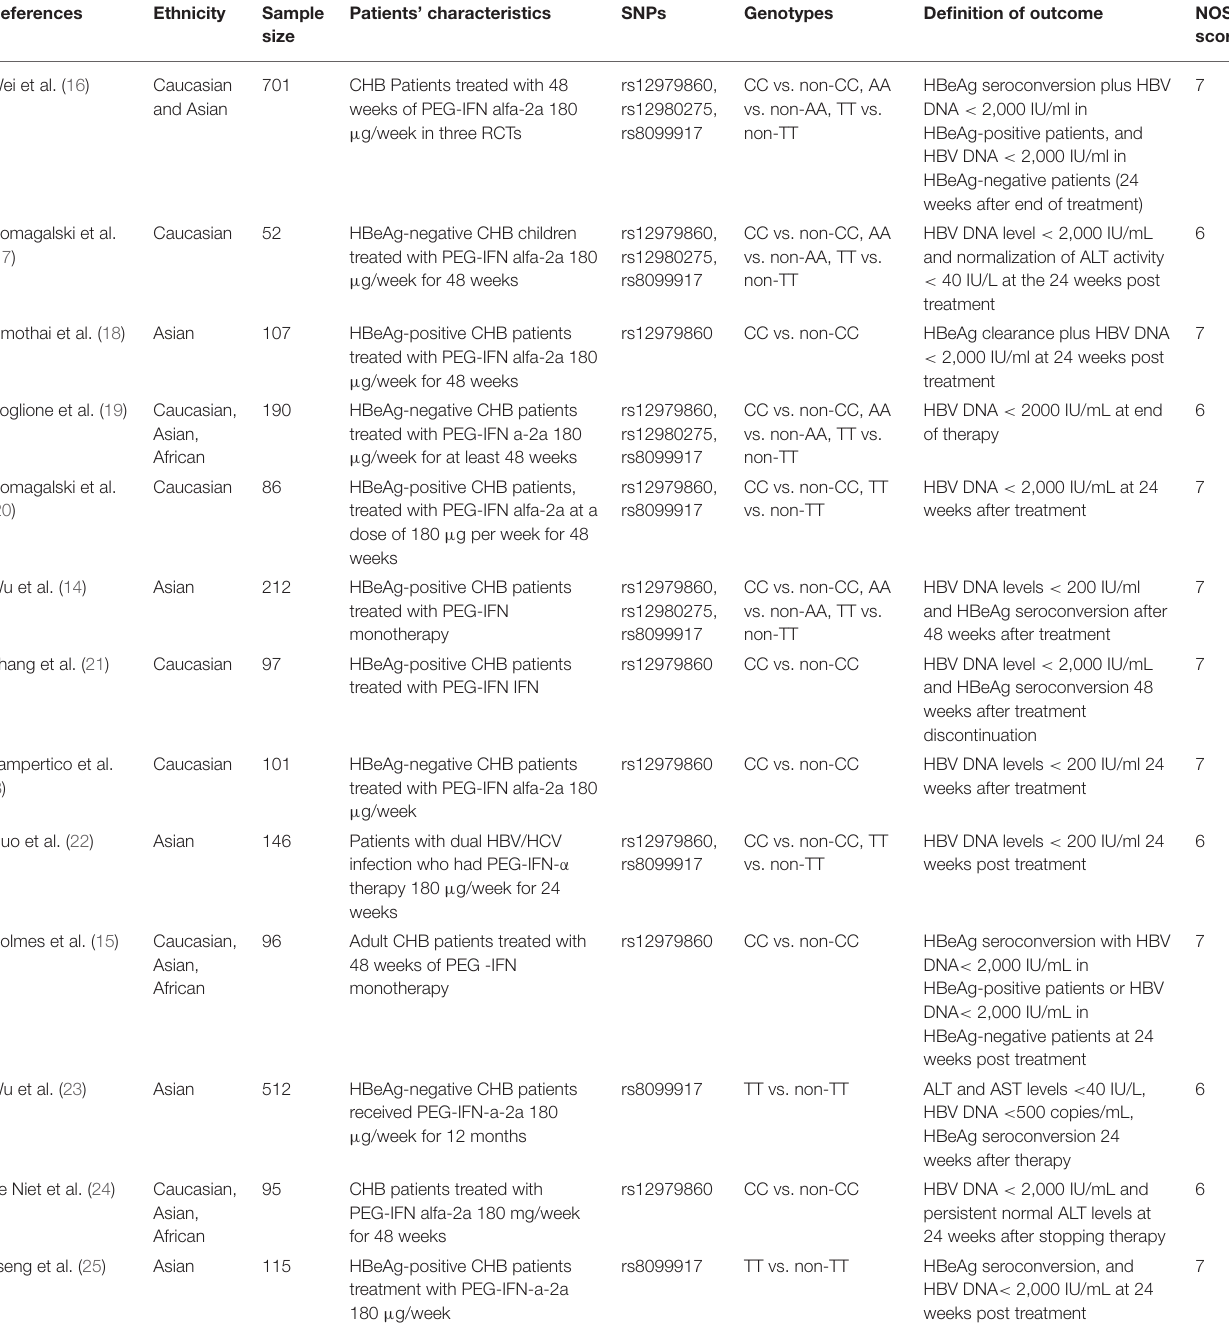
TABLE 1 | Characteristics of included